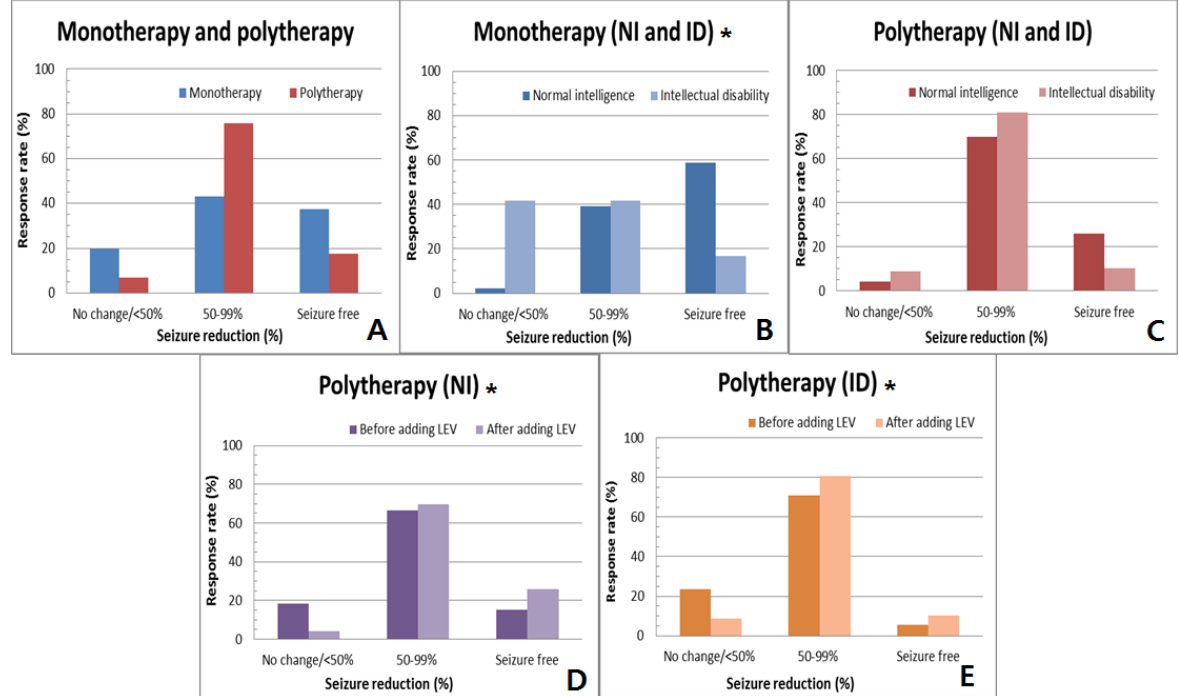
Figure 1. Efficacy after 6 months receiving LEV described in ( A – C ). ( A ) Comparing the efficacy of monotherapy and polytherapy, there was no significant difference in seizure reduction between two groups. ( B ) Comparing the efficacy of patients with NI and ID in monotherapy, patients with NI showed higher response rate of being seizure-free than those with ID (Chi-square test, p = 0.011). ( C ) Comparing the efficacy of patients with NI and ID in polytherapy, there was no significant difference of response rates between two groups. ( D , E ) Response rate of seizure reduction before and after addition of LEV in polytherapy. Both NI and ID groups were significantly affected by the addition of LEV (paired t -test, p = 0.033, p = 0.041, respectively). An asterisk indicates the statistically significant difference between the two groups; LEV, levetiracetam; NI, normal intelligence; ID, intellectual disability.